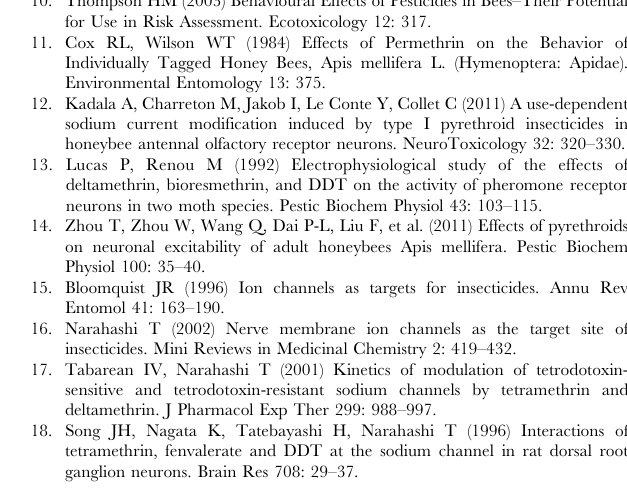
Figure S1 Fitting experimental data with the channel-state- model in control conditions allows to evaluate all parameters in control conditions. With these parameters, current traces (A, B), current–voltage curve (C, V act = 2 22 mV, k=9.2 mV), as well as progressive use-dependent current decrease during train of depolarizations (D) are correctly simulated (green traces channel model, black traces experimental data). (TIF) Figure S2 Numerical simulation of the model channel behavior. Simulation was performed during longer trains of depolarizations (30 pulses), in standard pyrethroid concentration (10 m M, green) and for 10 fold lower (red) or higher (blue) pyrethroid concentrations underlines the differences between the 3 drugs that can be further tested experimentally. (TIF) Figure S3 Fitting experimental data with the state-model incorporating binding to Open and/or Closed states. Modification in the rate constants using the state model on top and allowing binding of tetramethrin to Open or Closed states only or to both states. In the 3 cases the changes in rate constants were qualitatively similar, only Kds value were different, with respective Kd of 65 nM and 6.1 m M for binding to Open or Closed channels exclusively, or 61 nM and 15 m M for possible binding to Open and Closed states simultaneously.